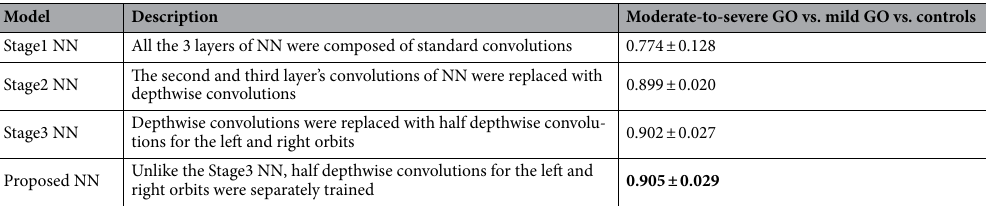
Table 3. Ablation study of proposed NN for Graves’ orbitopathy in terms of AUC. AUC area under the curve, GO Graves’ orbitopathy, NN neural network. Significant values are in